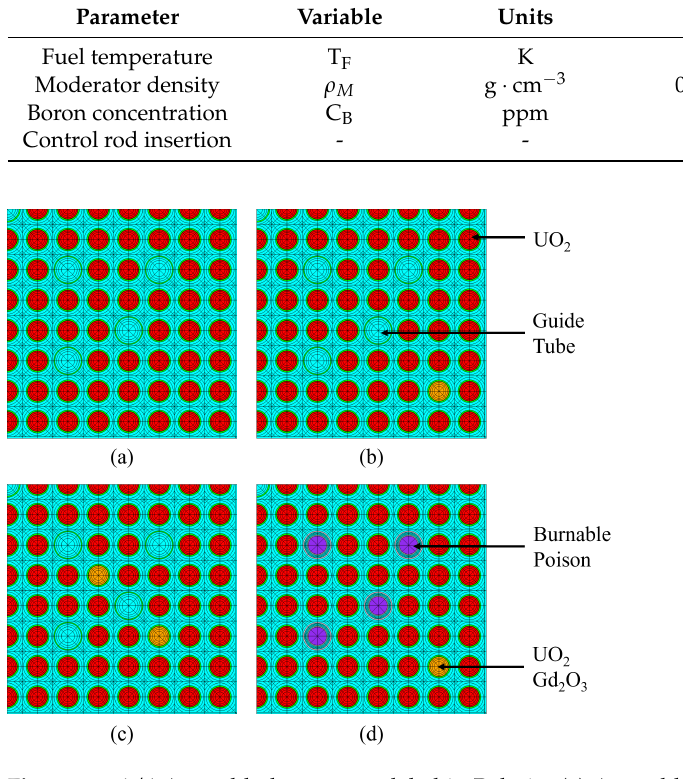
Figure 11. 1/4 Assembly layouts modeled in Polaris. ( a ) Assembly without burnable poisons or UO 2 -Gd 2 O 3 rods; ( b ) Assembly with 4 UO 2 -Gd 2 O 3 rods and without burnable poisons; ( c ) Assembly